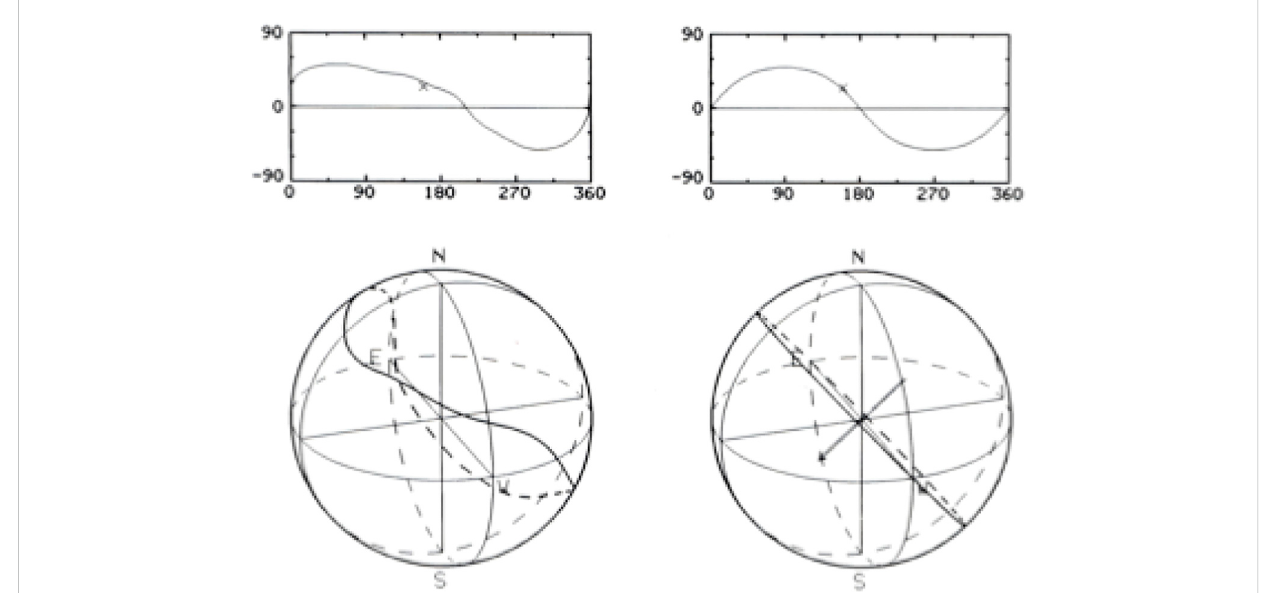
FIGURE 5 Left: Year, an example of the magnetic equator on the Carrington map and on the spherical source surface of CR 1720 shown in Figure 3 (but is rotated by 180 ° for the comparison). Right: A simple sine wave case; it shows also the equivalent dipole axis.